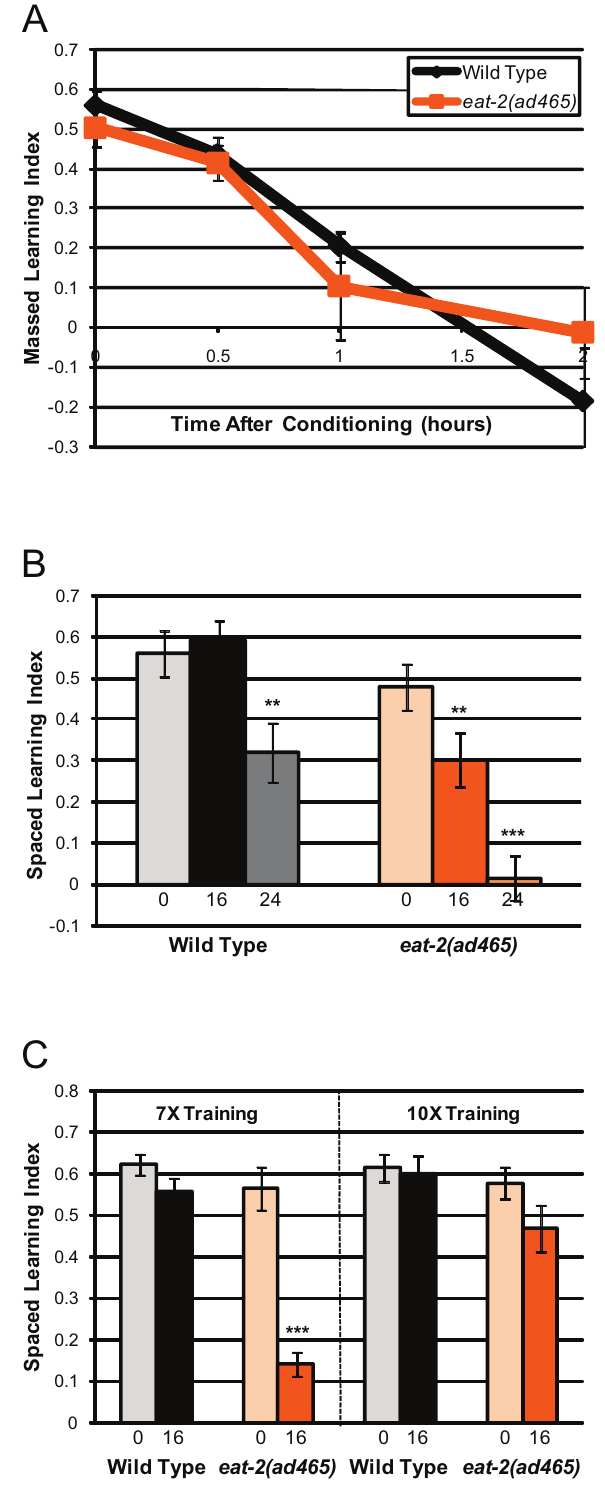
Figure 6. Dietary restriction impairs Day 1 long-term memory. (A) eat-2(ad465) mutants have normal massed learning and short-term memory. (B) eat-2(ad465) mutations impair long-term memory after spaced training. (C) Increasing spaced training blocks from seven to ten improves the defective 16 h memory of eat-2(ad465) animals. Numbers under bars represent hours after 7 6 spaced training. (A–C): n =6 trials, 6 SEM; ** p , 0.01, *** p , 0.001.